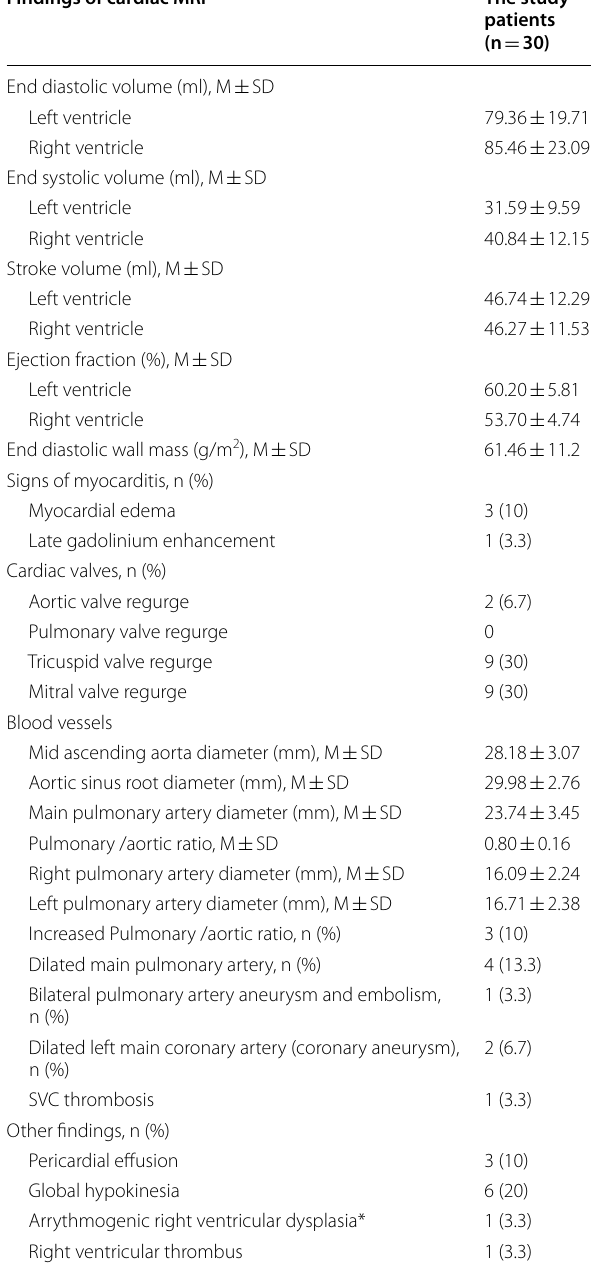
Table 2 Findings of cardiac MRI of the studied Behçet’s